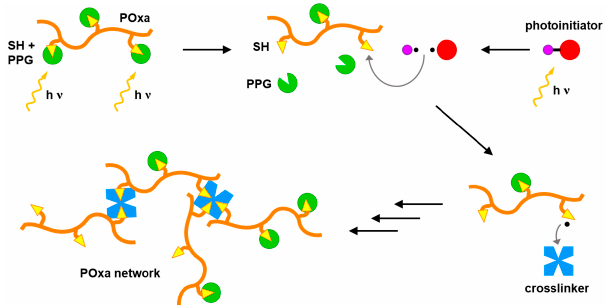
Figure 1. Schematic strategy of the tandem network formation by concurrent photodeprotection and thiol-ene click crosslinking (‘POxa’: poly(2-oxazoline), ‘PPG’: photoremovable protecting group, ‘ SH ’: thiol group).